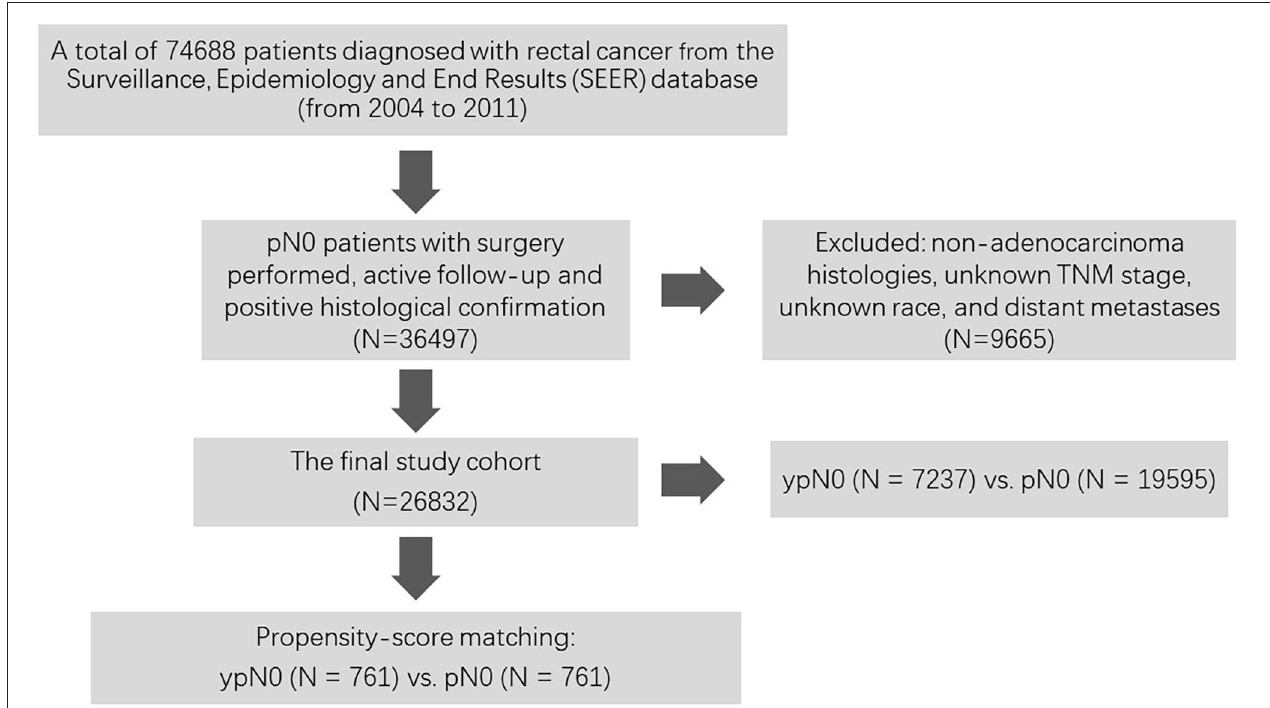
FIGURE 1 | Flow diagram of the patient selection and research